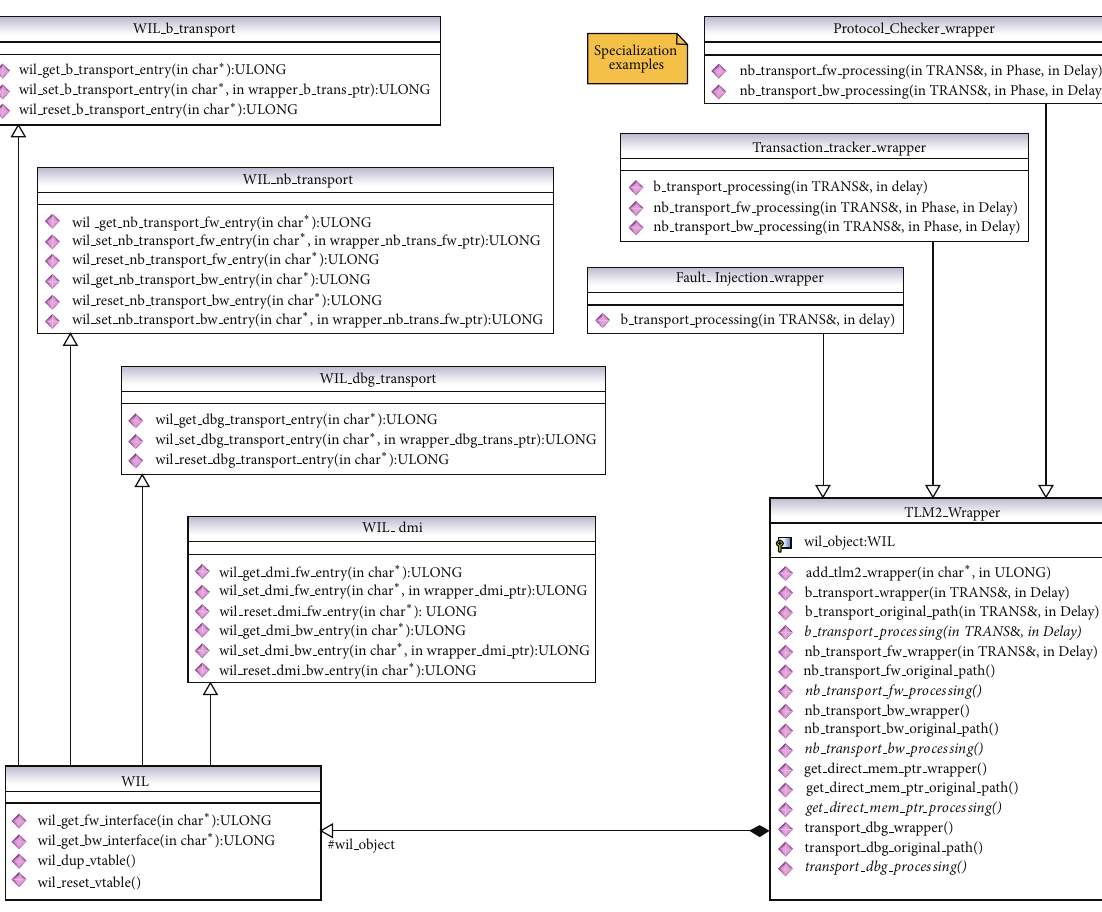
Figure 6: TLM2 wrapper class